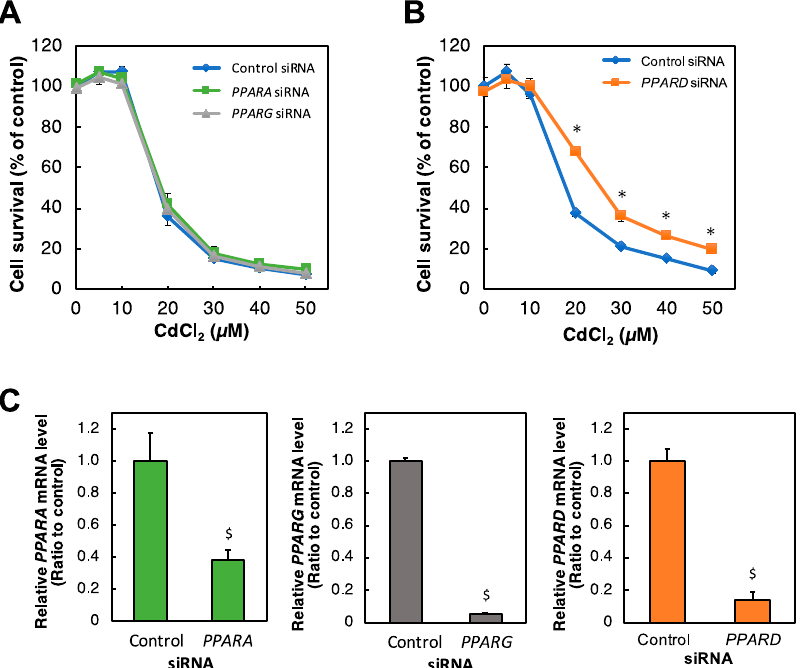
Figure 1. Effect of PPAR knockdown on the survival rate of HK-2 cells treated with Cd. ( A , B ) After treatment with PPARA , PPARG or PPARD siRNA for 48 h, HK-2 cells were treated with Cd for 24 h. Cell survival was examined by an Alamar blue assay. Values are means ± SD ( n = 3). * Significantly different from the control siRNA group, p < 0.05. ( A ) PPARA siRNA and PPARG siRNA. ( B ) PPARD siRNA. ( C ) Efficiency of PPARA, PPARG, and PPARD knockdown was examined after HK-2 cells were treated with siRNA against the gene of PPARA , PPARG or PPARD for 48 h. PPARA , PPARG , and PPARD mRNA levels were examined by real-time RT-PCR and normalized to GAPDH mRNA levels. Values are means ± SD ( n = 3). $ Significantly different from the control group, p <